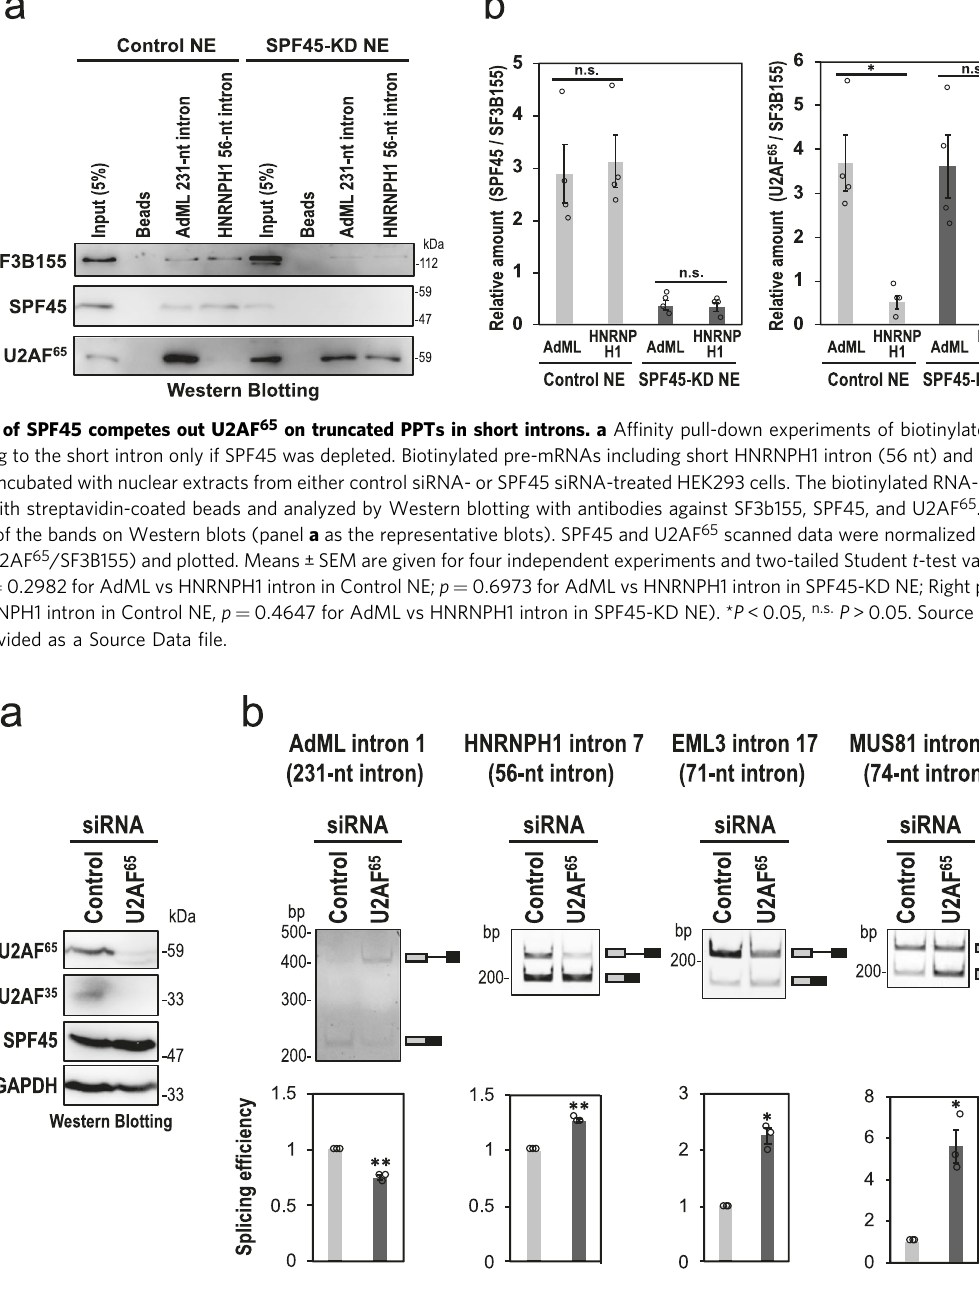
proteins from HeLa cells was observed by a Western blotting. Displayed blots are representative of three independent experiments. b After the siRNA transfection, HeLa cells were cultured for short time (4 h) to effectively observe splicing stimulation, and splicing ef fi ciencies of the indicated four mini genes were analyzed by RT-PCR. Means± SEM are given for three independent experiments and two-tailed Student t -test values were calculated (AdML intron: p = 0.0067 for Control vs U2AF 65 siRNA; HNRNPH1 intron: p = 0.0038 for Control vs U2AF 65 siRNA; EML3 intron: p = 0.0116 for Control vs Data fi le.